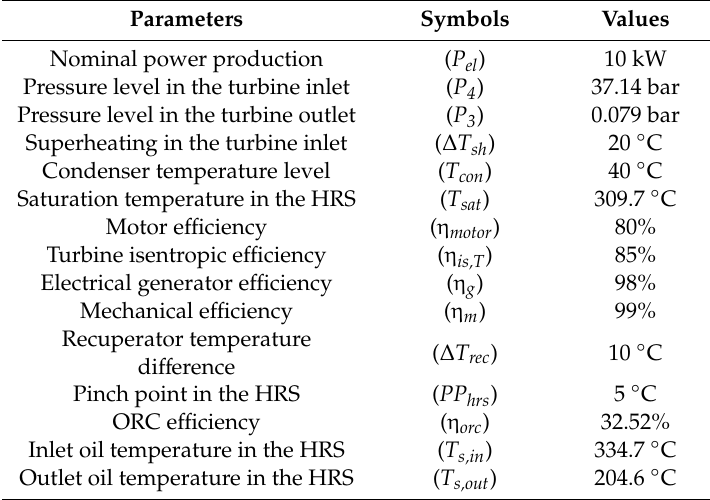
Table 2. Parameters of the organic Rankine